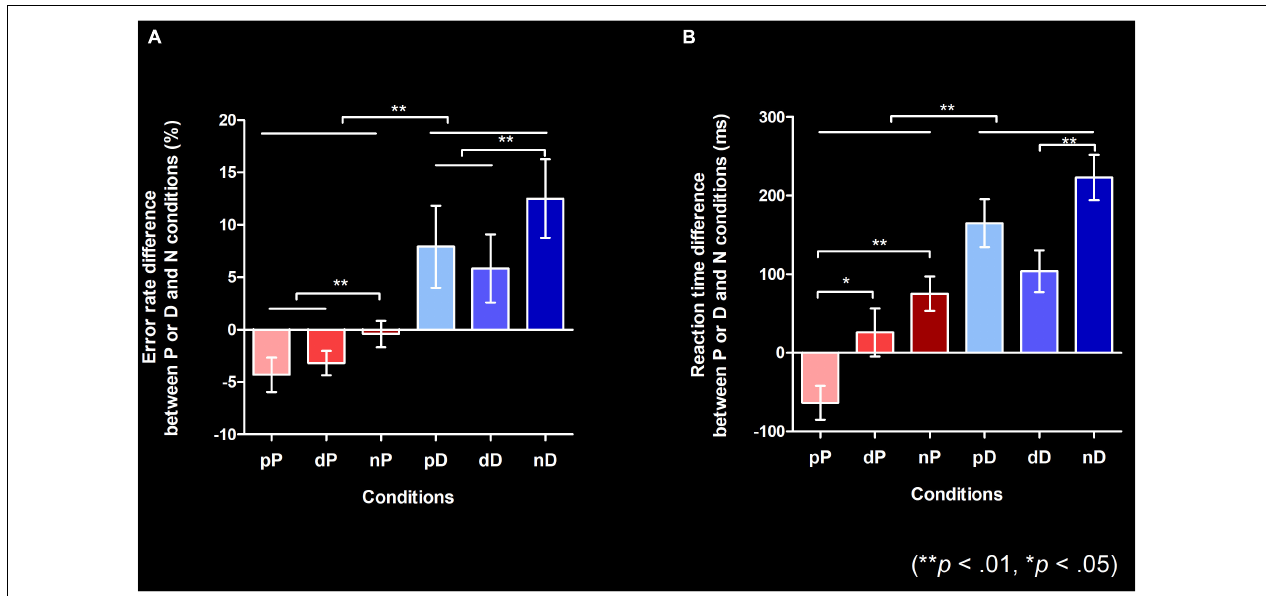
FIGURE 3 | Behavioral results (** p < 0.01, * p < 0.05; Bonferroni-corrected). Both error rate (A) and reaction time (B) data in this figure show the relative difference compared to the No structure condition. (A) The relative error rate from the N condition for P and D conditions. Error bars indicate the standard error of the mean (SEM). All responses other than PO (verb followed by a noun phrase that behaved as a patient/theme + a prepositional phrase that behaved as the beneficiary) or DO (verb immediately followed by a noun phrase that behaved as the beneficiary + a noun phrase that behaved as the patient/theme) were coded as errors. (B) The relative reaction times from the N condition for P and D conditions. Error bars indicate the SEM. Reaction time indicates the time measured from the point when the colored objects were presented to when participants started uttering the first word. Error responses were excluded from the data used in this figure. P, D, and N represent Prepositional Object trials (PO), Double Object trials (DO), and No structure trials, respectively. The target trial is notated in upper case font, with the preceding trial (prime) in lower case